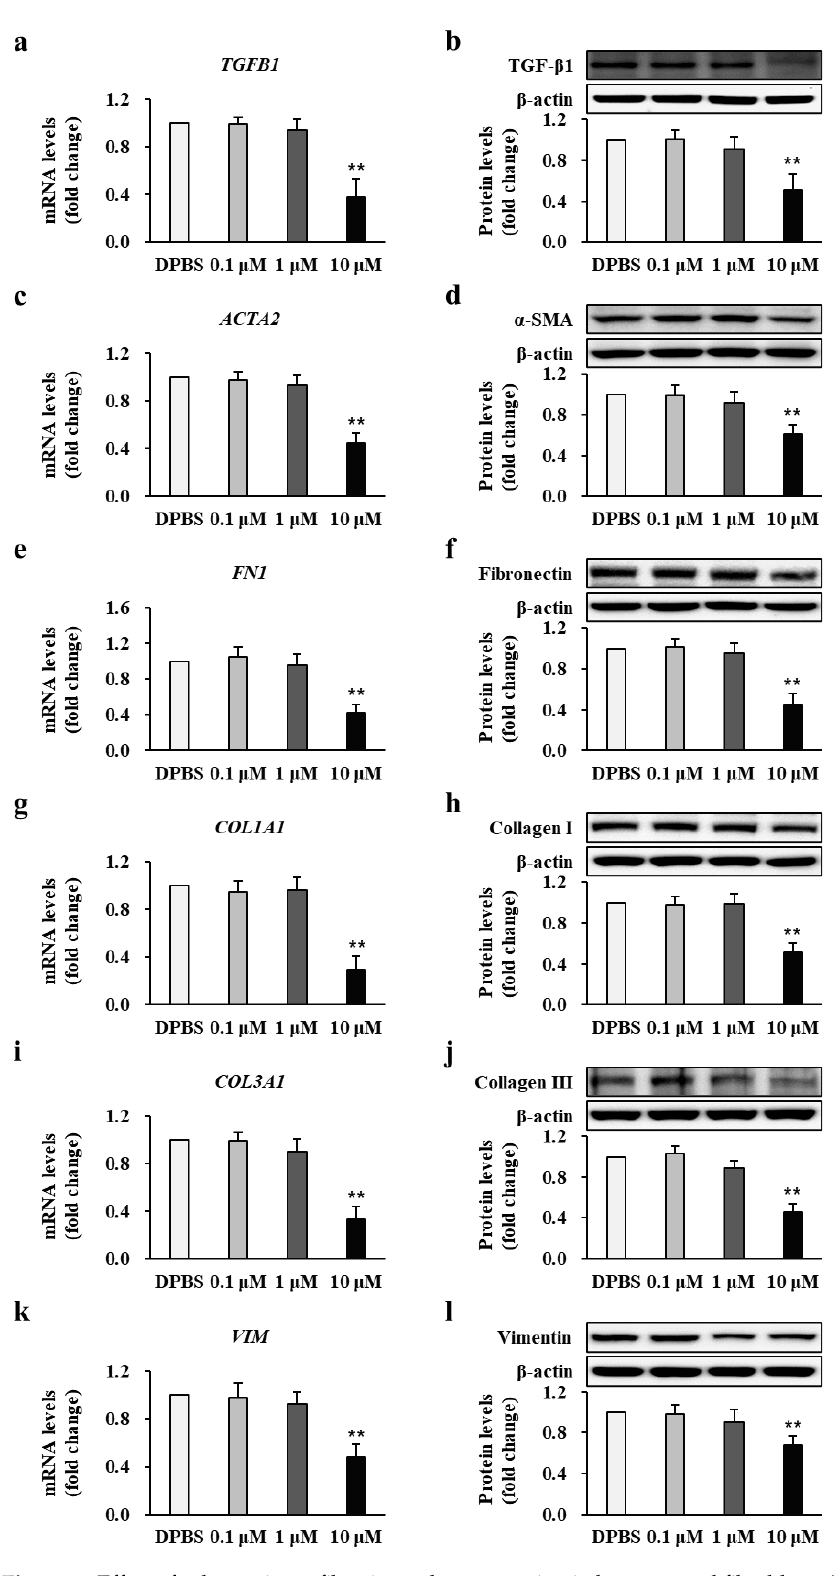
Figure 5. Effect of calpastatin on fibrotic marker expression in burn-wound fibroblasts (BFs) of patients. The mRNA and protein levels of ( a , b ) TGF- β 1 ( TGB1 ), ( c , d ) α -SMA ( ACTA2 ), ( e , f ) fibronectin ( FN1 ), ( g , h ) collagen I ( COL1A1 ), ( i , j ) collagen III ( COL3A1 ), and ( k , l ) vimentin ( VIM ) were significantly decreased in 10 µ M calpastatin-treated BFs compared with Dulbecco’s phosphate-buffered saline (DPBS)-treated BFs (DPBS). All expression levels were normalized to those in DPBS-treated BFs for each patient. ** p < 0.01. Data represent mean ± standard error of the mean; n = 34 (each